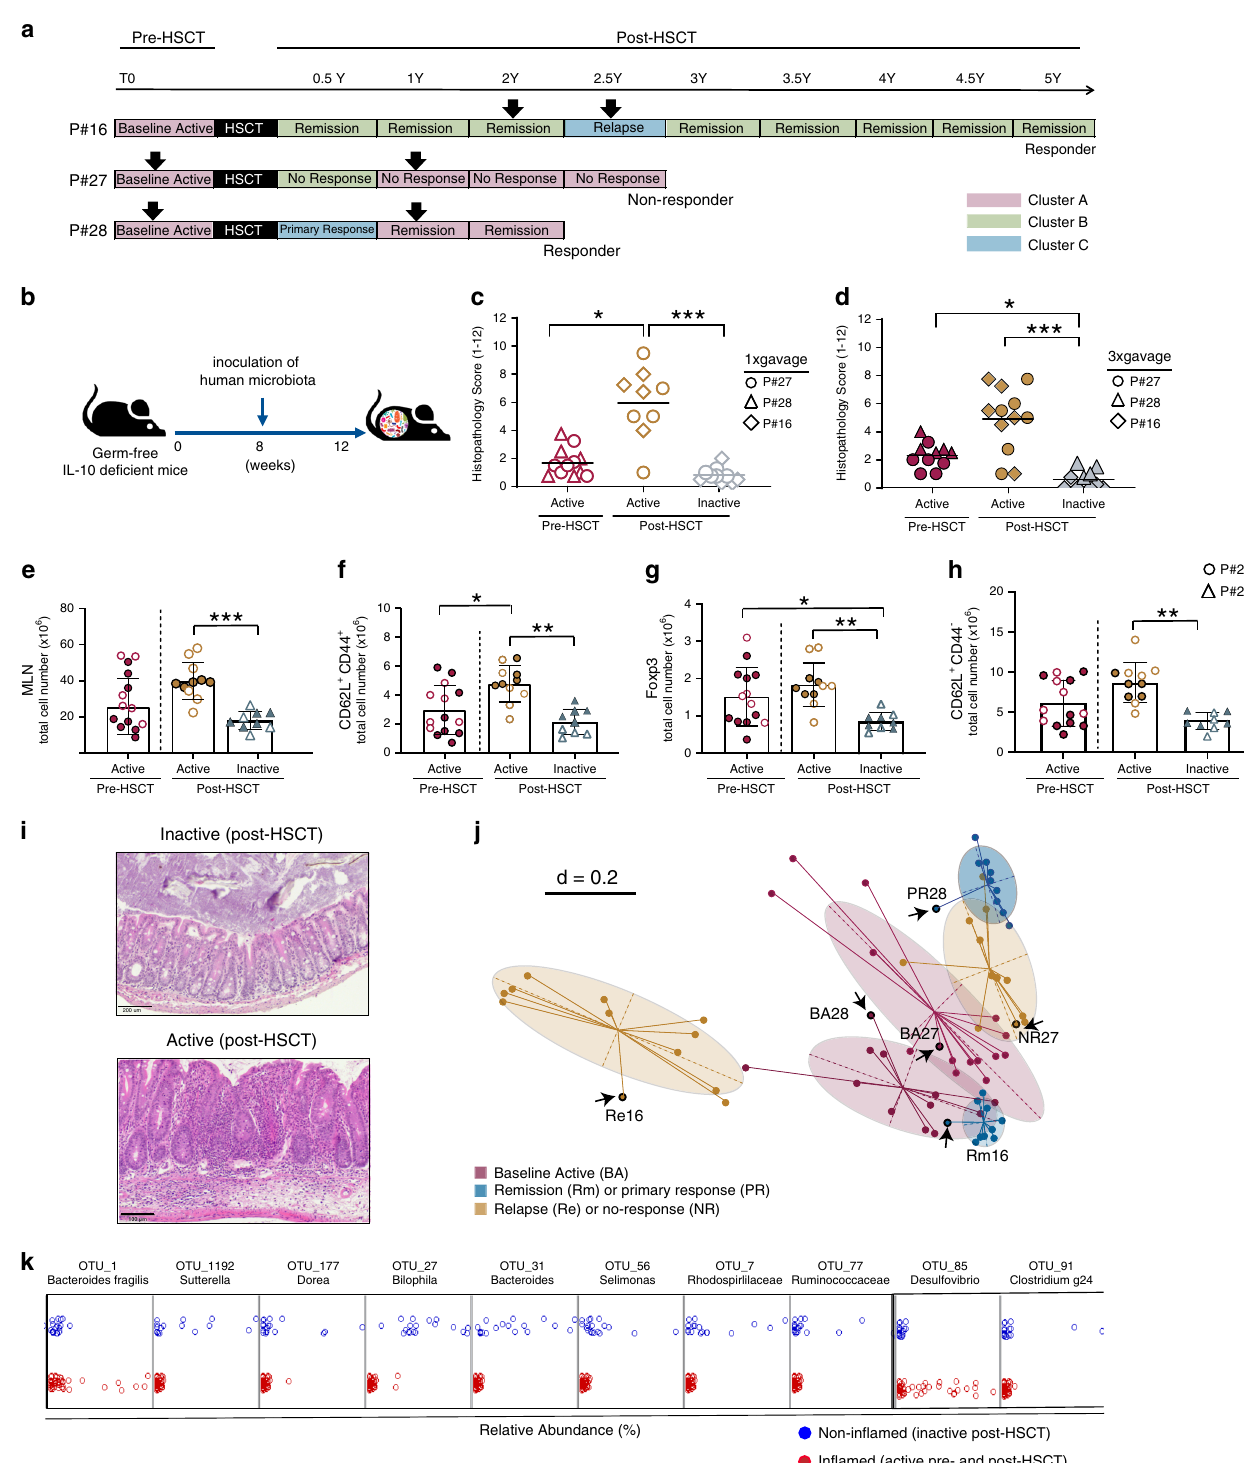
performed UHPLC-TOF-MS metabolite pro fi ling using reversed- phase ultra-high-performance liquid chromatography (RP- UHPLC) and hydrophilic interaction ultra-high-performance liquid chromatography (HILIC-UHPLC). In combination, these techniques cover polar and nonpolar metabolites and spectral features were detected. The number of features annotated after preprocessing, peak picking, and removal of near-zero variance features is summarized (Supplementary Table